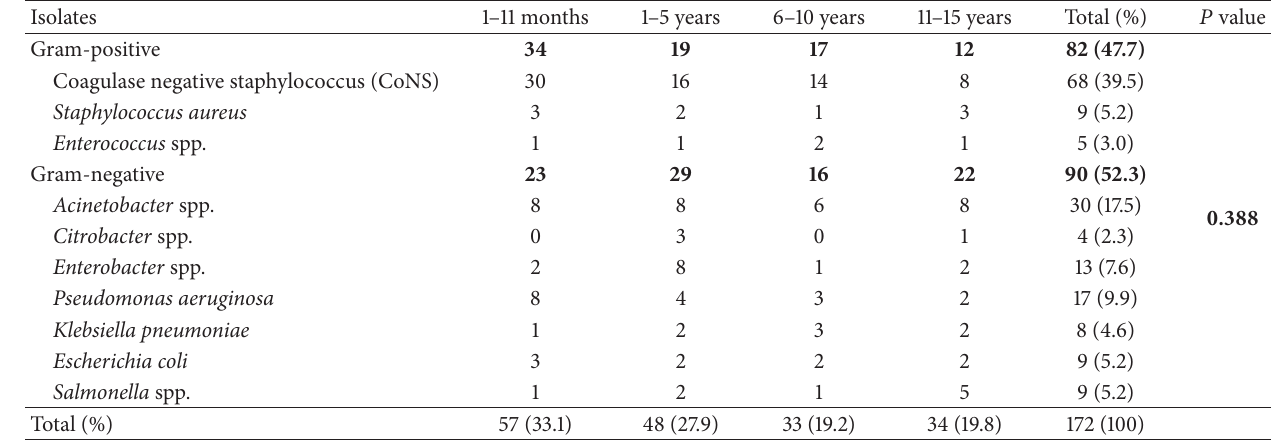
Table 2: Distribution of bacterial